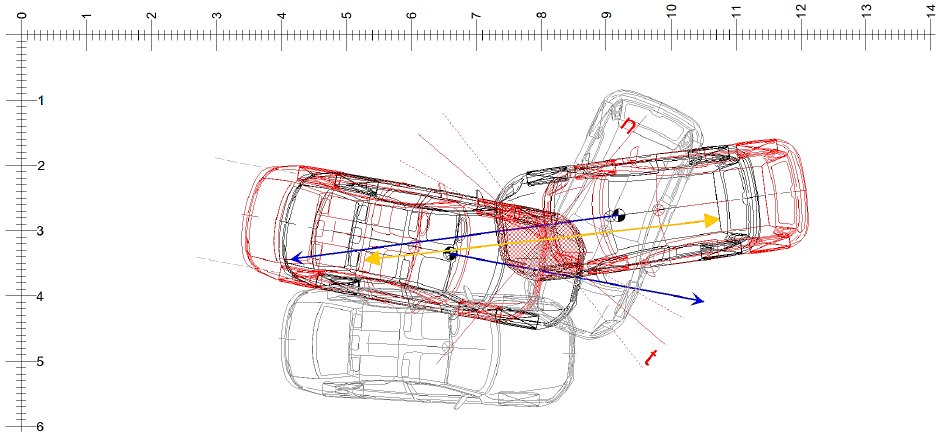
Figure 2. The collision of two passenger vehicles with the front wheels locked.